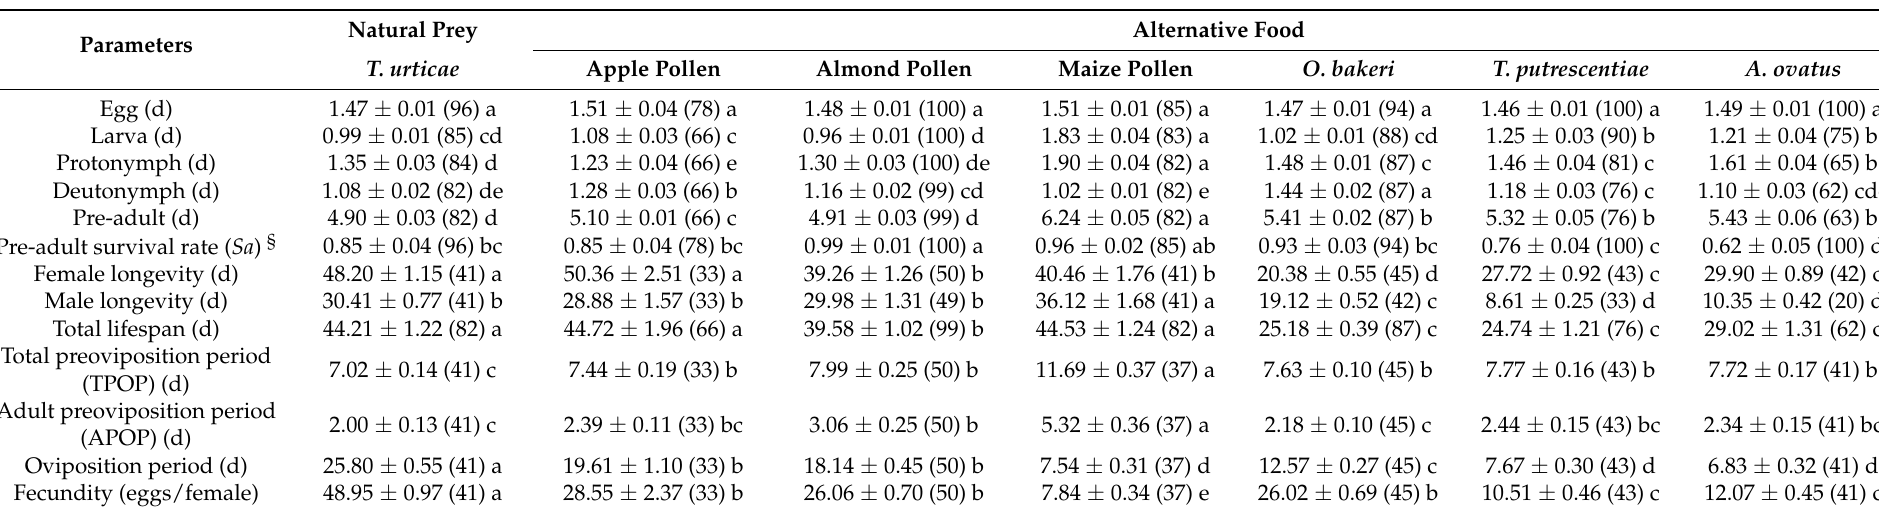
Table 1. Development duration, longevity, and fecundity of A. herbicolus feeding on six alternative foods and its natural prey, T. urticae .